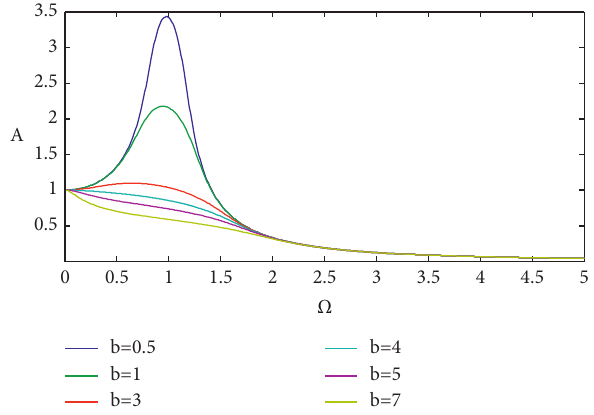
Figure 4: Amplitude-frequency ratio diagram for different b .